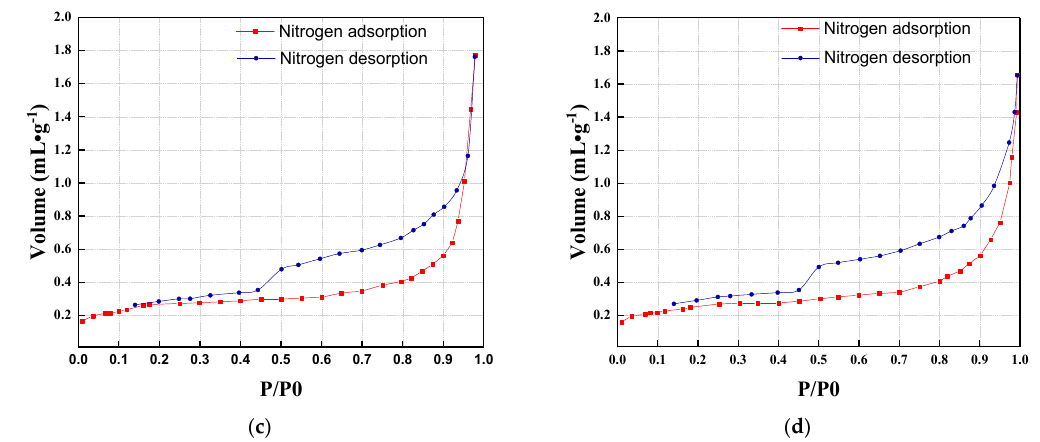
Figure 6. N 2 adsorption-desorption of different coal samples. ( a ) Tectonic coal; ( b ) virgin coal; ( c ) virgin coal and mixed coal with the mass ratio of 2:4; ( d ) virgin coal and mixed coal with the mass ratio of 3:3.